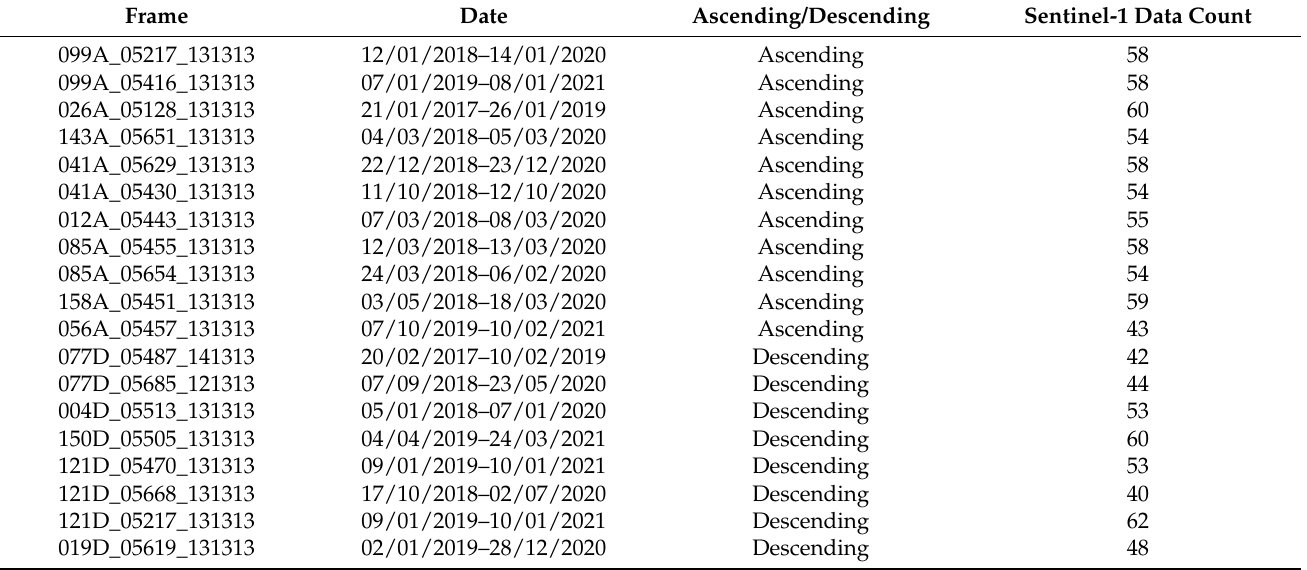
Table 1. The Sentinel-1 data information used in this